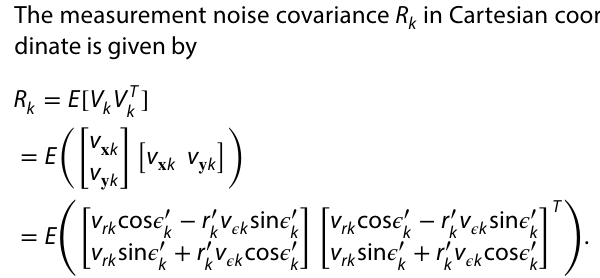
Fig. 9 RMSE plot of RSCQKF, RSCKF, CQKF and CKF for 𝐲 -velocity (in km/s) of the